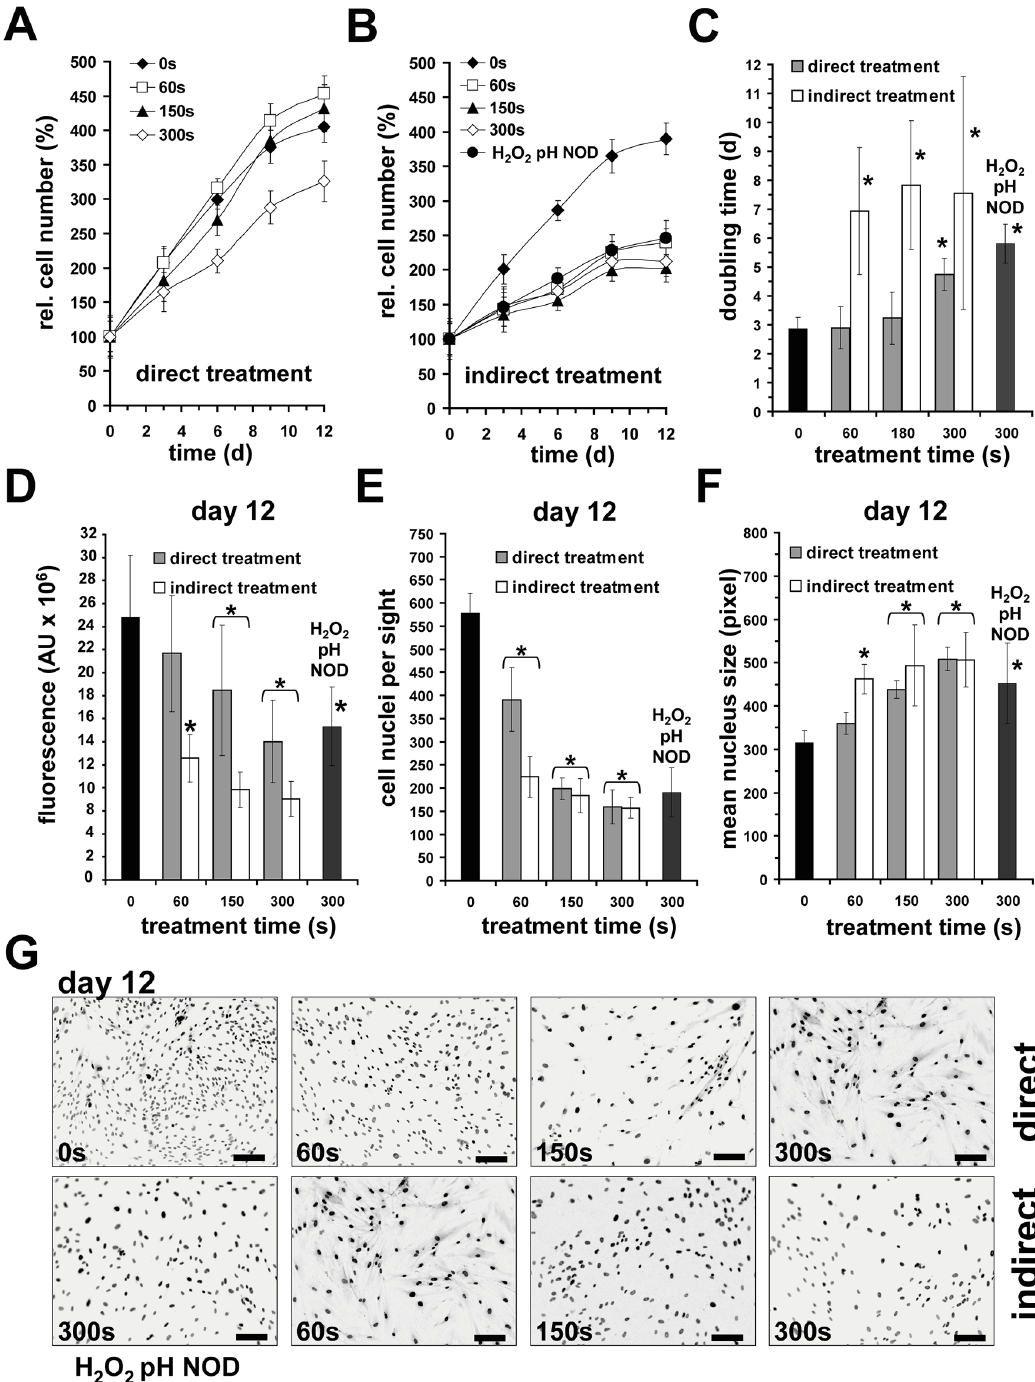
Fig 3. DBD treatment inhibits proliferation of human dermal fibroblasts. A Proliferation curve of remaining fibroblasts after direct DBD treatment measured by a resazurin-based assay. B Proliferation curve of remaining fibroblasts after exposure for 5 min to buffer, which was DBD-treated as indicated (indirect treatment). Additionally, fibroblasts were exposed to acidified buffer ( pH 6.7) containing nitrite/nitrate ( NOD; 300 μ M / 1.0 mM) and H 2 O 2 (200 μ M). C The calculated doubling times for proliferation curves A and B. D Values obtained by resazurin-based assay on day 12 after treatment. E Counted Hoechst 33342-stained nuclei on day 12 after treatment. F Quantification of mean fibroblast nucleus size on day 12 after treatment. G Representative microphotographs of Hoechst 33342-stained nuclei of fibroblasts on d12 after treatment. Bars = 200 μ m. Given are the mean ± sd values (n = 5), * P < 0.05 as compared with the control